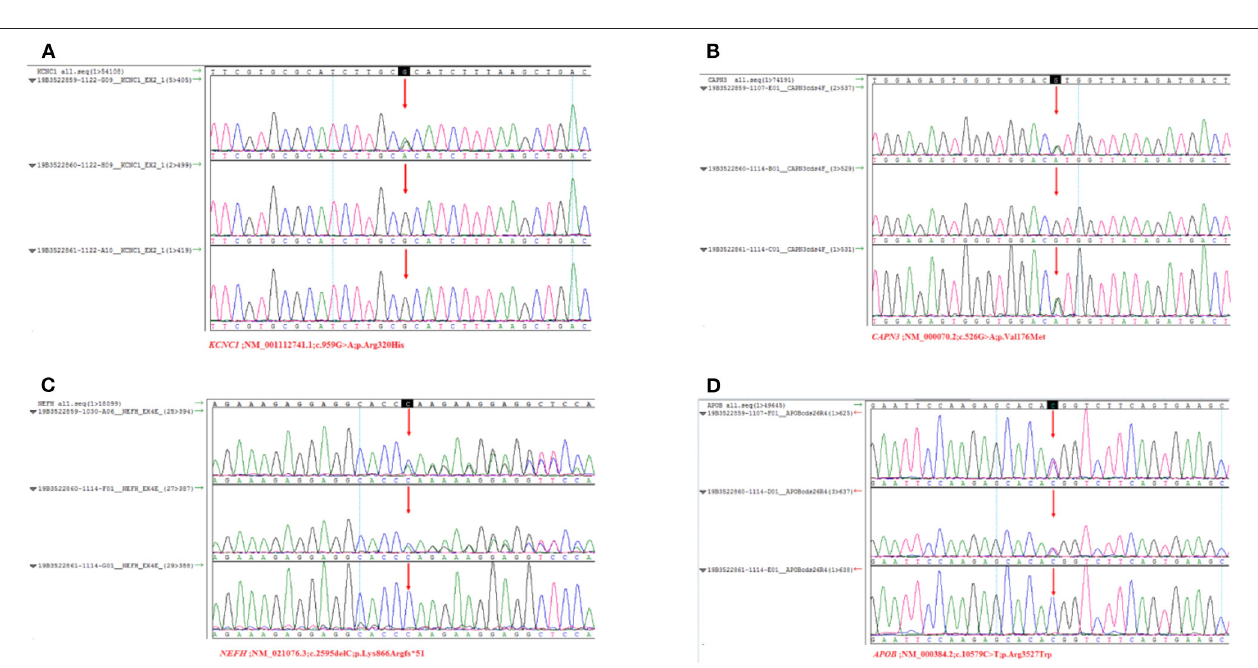
these mutations, KCNC1 was a de novo mutation, and the latter two mutations were inherited from the proband’s father and